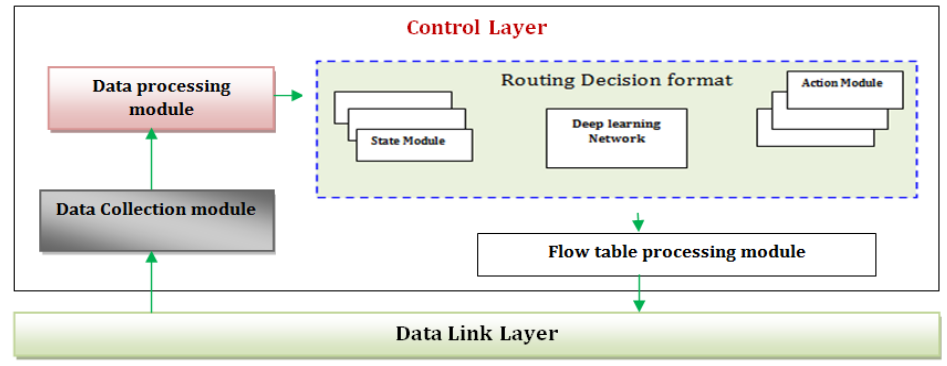
Figure 2. DL based Routing model.